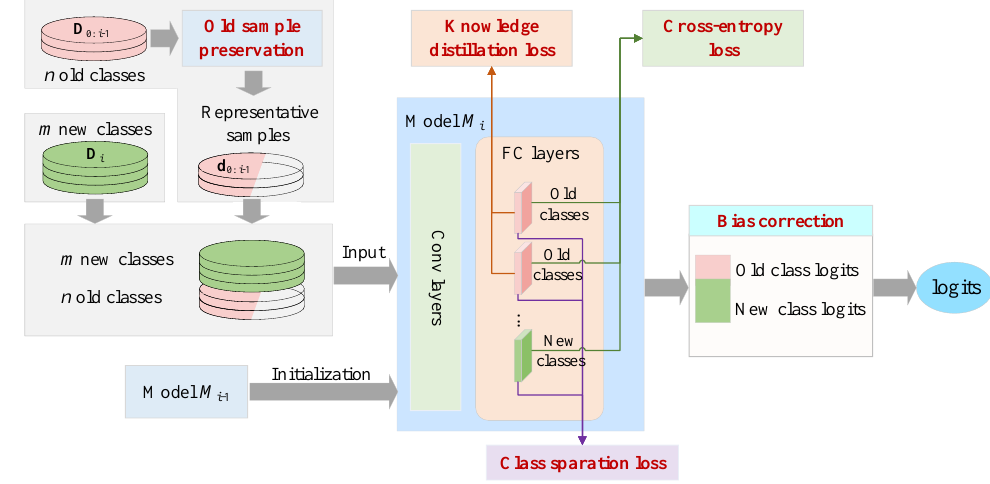
Figure 2. Illustration of one incremental phase of the proposed SAR target incremental recognition method based on hybrid loss function and class-bias